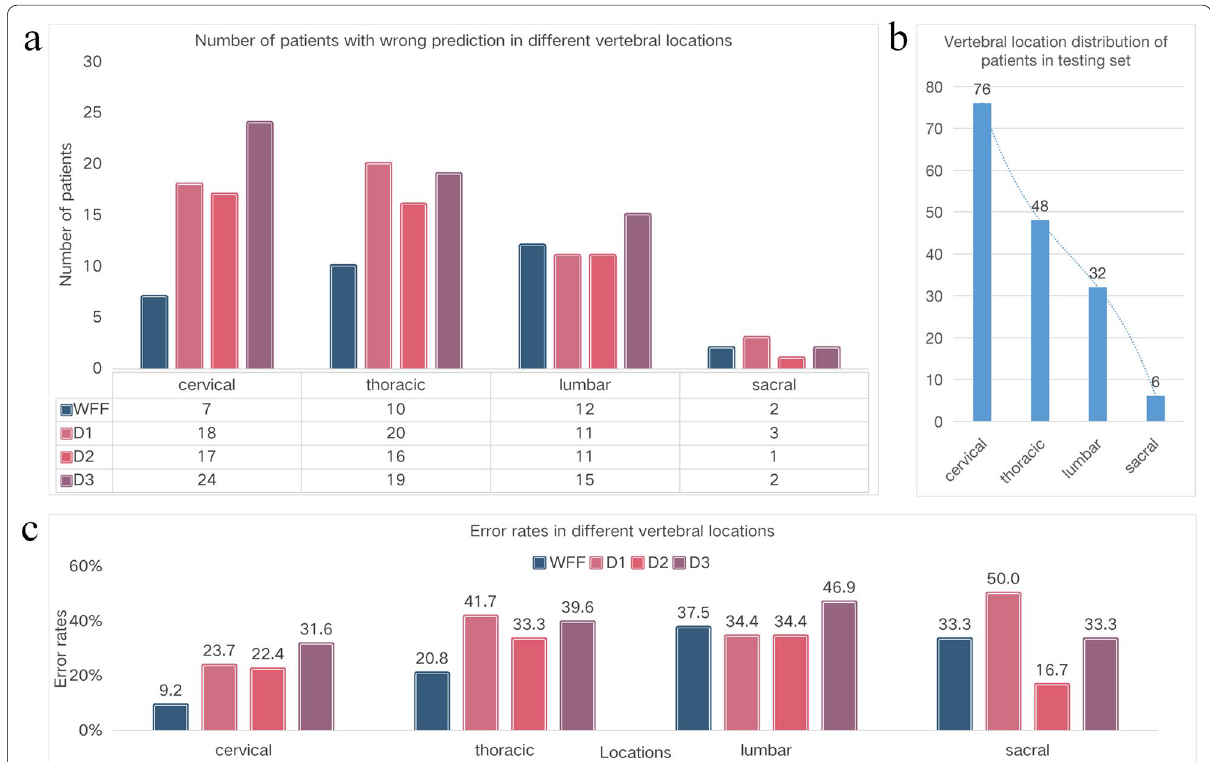
Fig. 6 a Number of patients with wrong prediction in different vertebral locations. b Vertebral location distribution of patients in the testing set. c Error rates in different